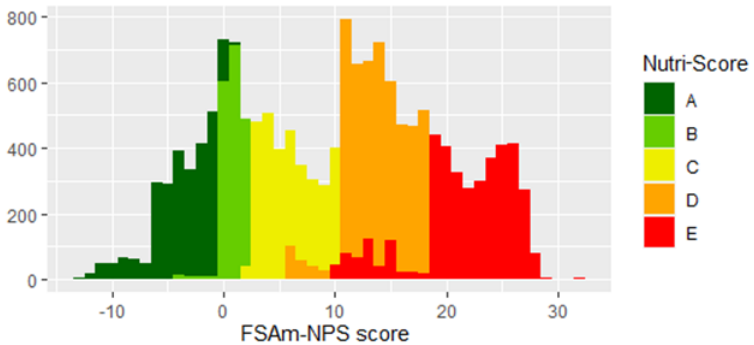
Figure 1. Overall distribution of FSAm-NPS score across the Slovenian food supply ( n = 15,822). Letters from A to E represent five Nutri-Score grades.